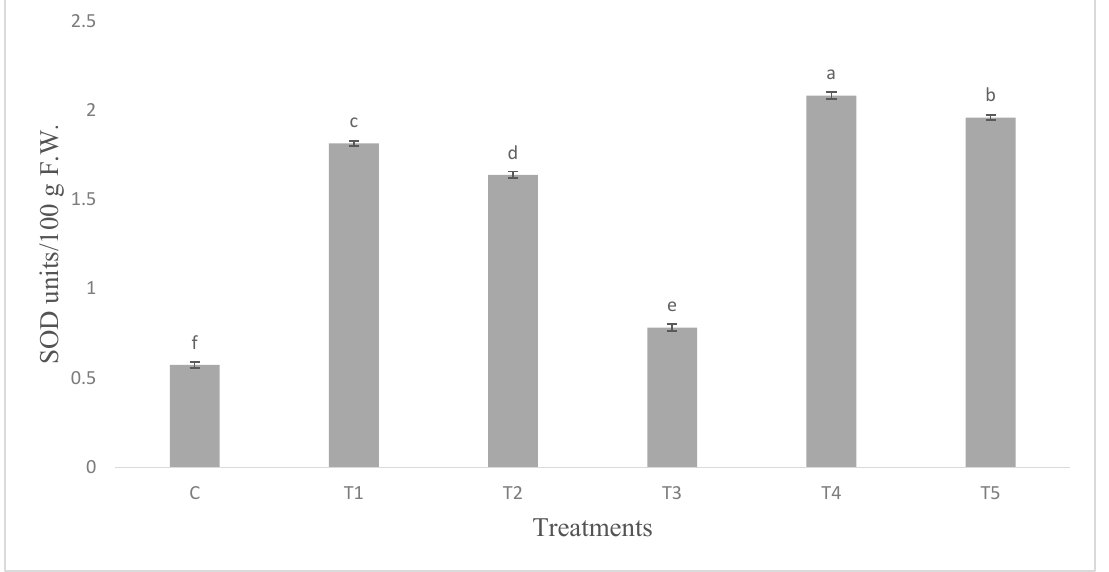
Figure 9. Superoxide dismutase (SOD) activity in tomato leaves infested with S. litura and under control condition. Data are means of four replicates along with standard error bars. Different letters are indicating significant differences ( p < 0.05) among treatments.